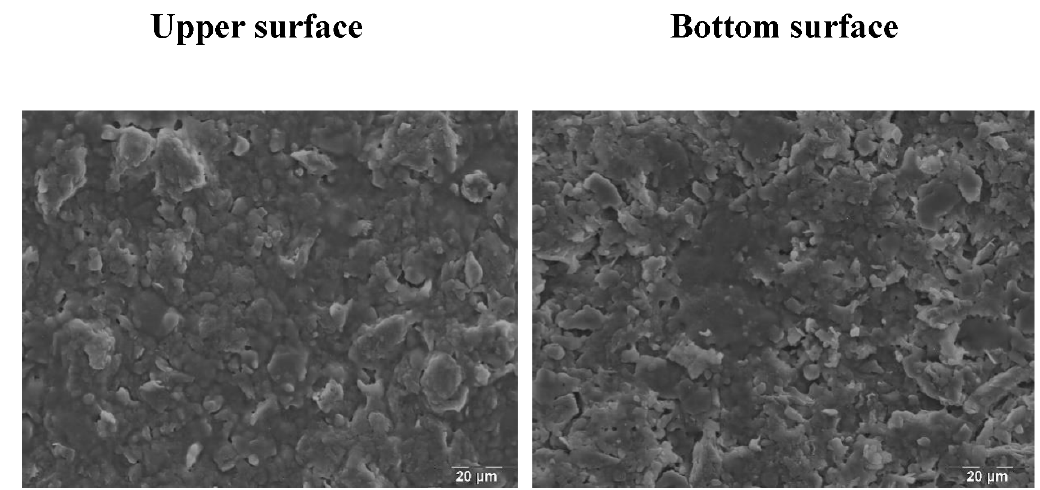
Figure 10. SEM images of K50T50 tapes sintered at 1100 °C.